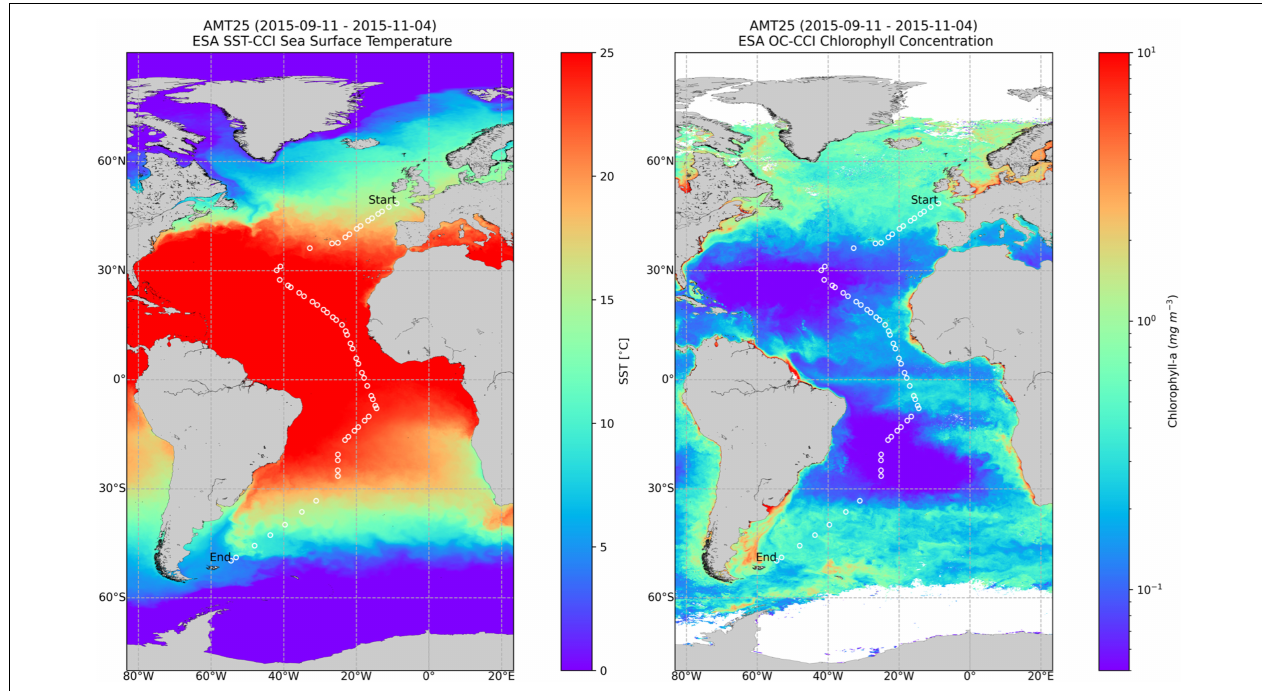
FIGURE 1 | Composite images of Sea Surface Temperature (SST), left, and Chl a , right, obtained from September 11, 2015 until November 4, 2015, showing the cruise track with the sampling stations. Chl a image was obtained from the OC-CCI portal (www.oceancolour.org). Courtesy of